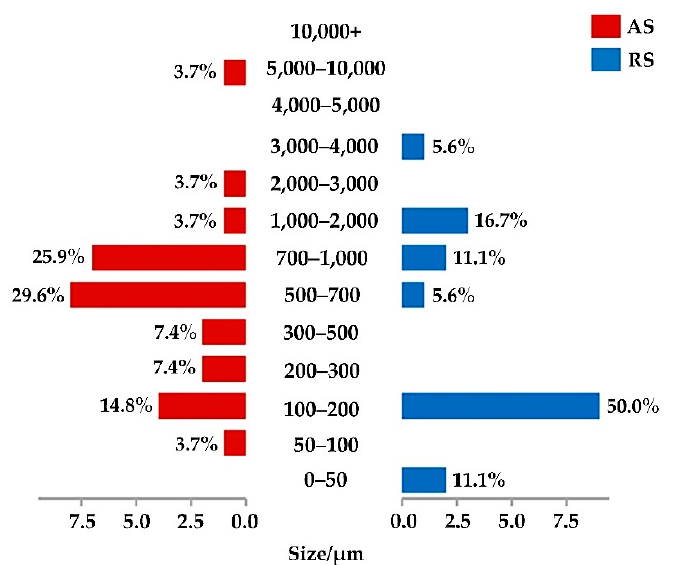
Figure 4. The quantities and percentages of different size ranges of MPs in order Perciformes of the AS and the RS, Antarctica.